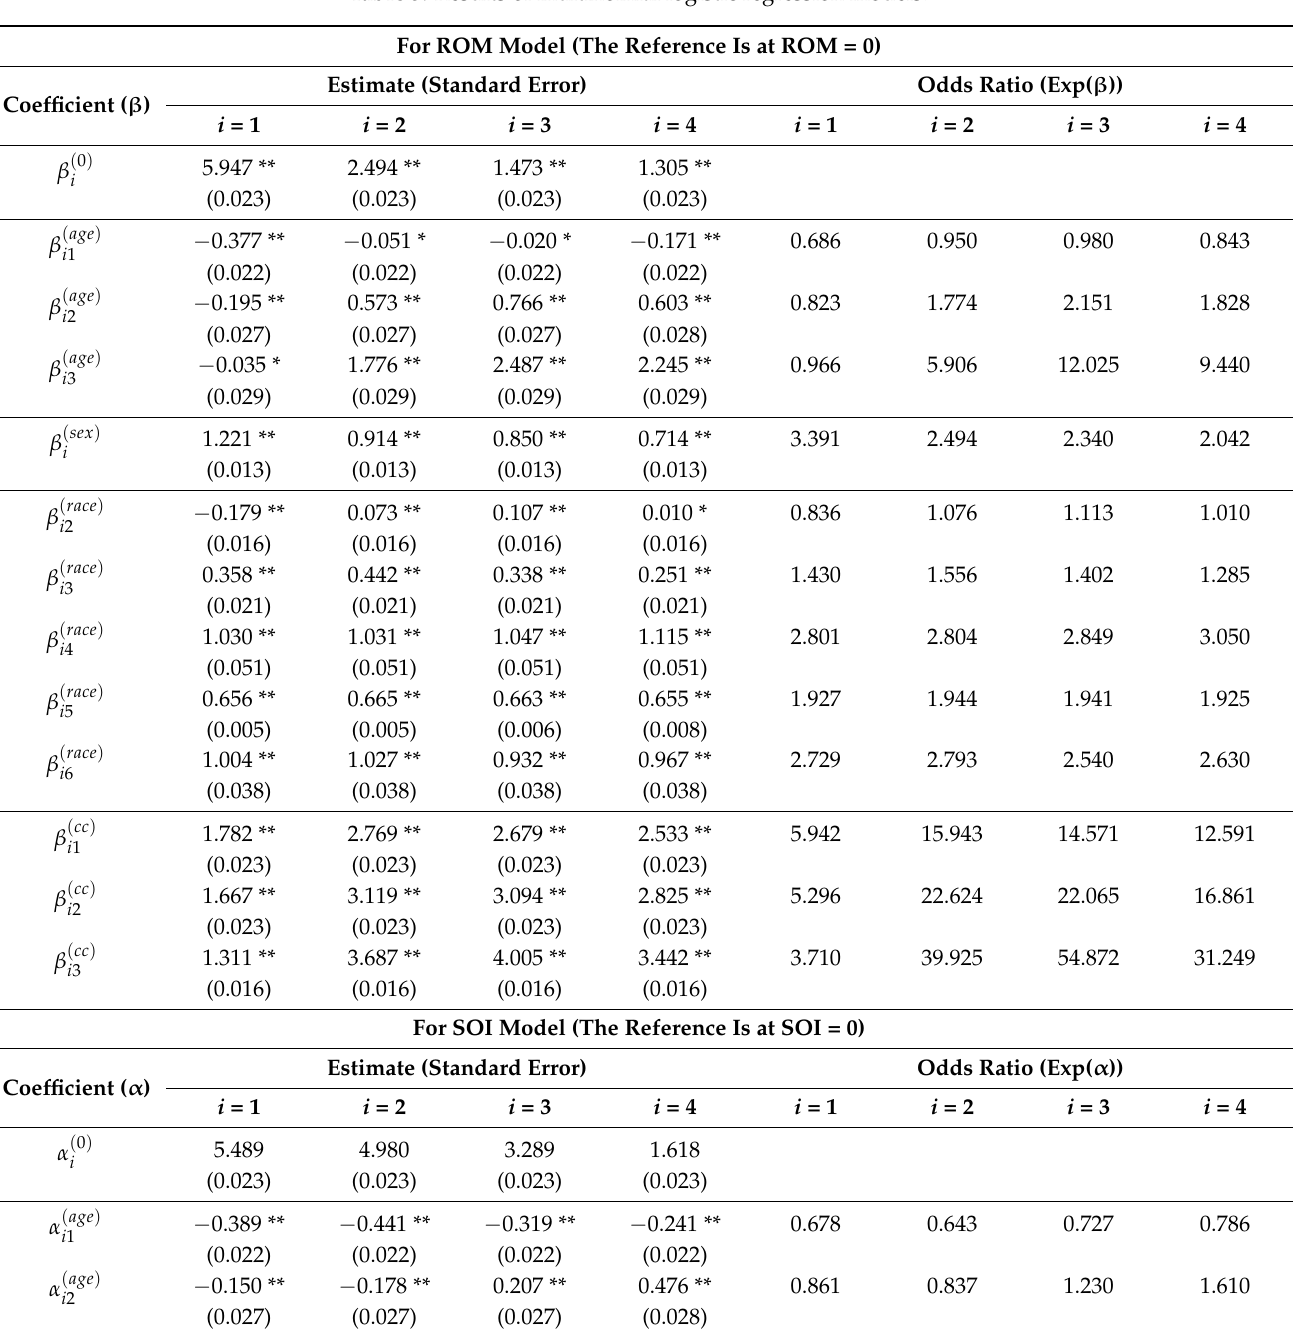
Table 5. Results of multinomial logistic regression